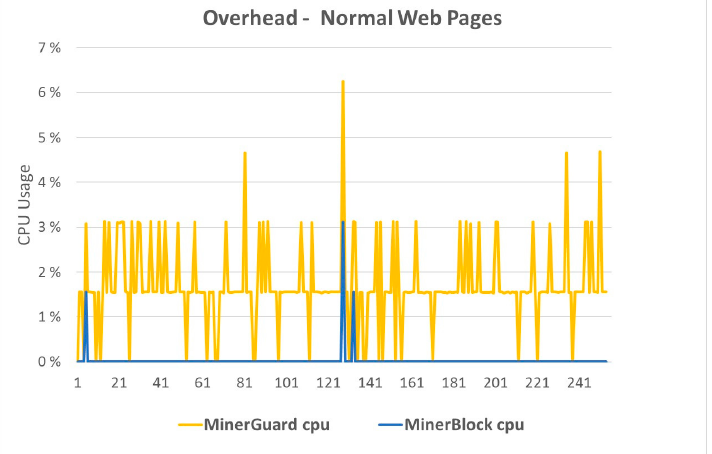
Figure 17. Resource usage overheads for handling normal web